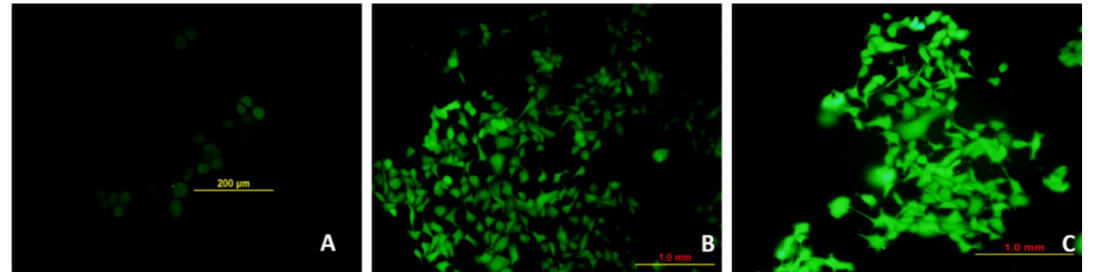
Figure 5. Effect of EP on production of ROS in MCF-7 cell lines. ( A ) Control ( B ) Treated with EP (40 µ g/mL), ( C ) Treated with EP (80 µ g/mL). ROS is an important parameter and it can be capable of producing free radicals and induced severe cell death compared to normal cells. Intracellular ROS levels were detected by fluorescent H 2 DCF-DA dye. The bright fluorescence in B and C indicating the production of ROS by inducing stress to the treated cells.